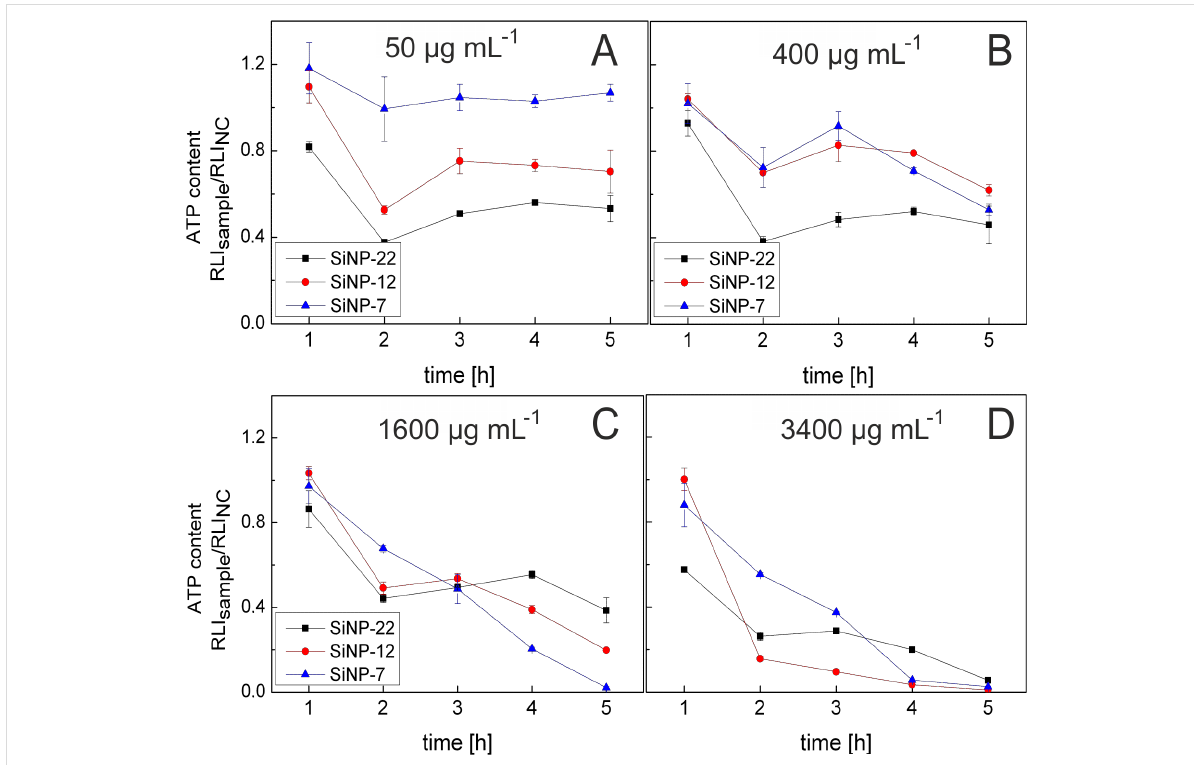
Figure 7: Measurement of intracellular ATP depletion. HeLa cells were exposed to SiO 2 NPs at different NP concentrations as indicated. The extent of extracellular ATP is expressed as a normalized quotient to the negative control.